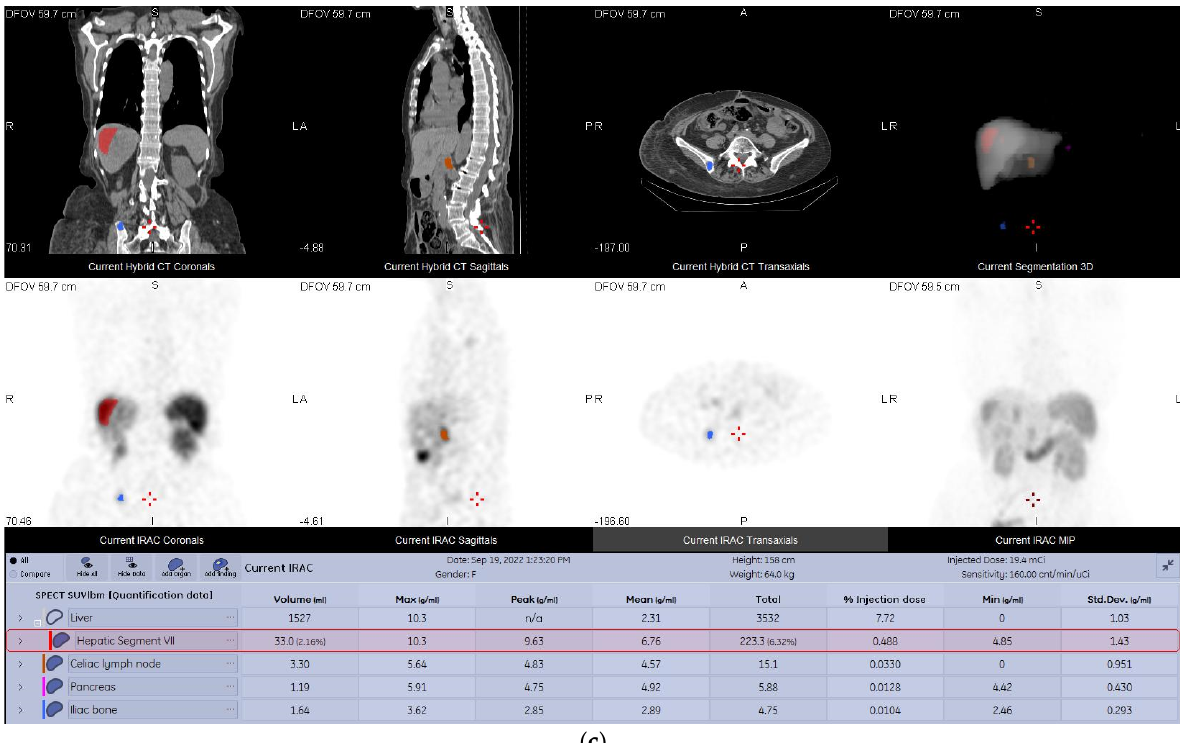
Figure 4. Comparison between a baseline and a follow-up scan of a 69 − year − old female patient suffering from pancreatic NET, treated with long acting somatostatin analogues. The comparative analysis between the baseline scan and the follow − up scan ( a ) shows a decrease in uptake both in the primary tumour (the pancreas) and in the liver metastasis. However, when analysing the two lesion segmentation processes separately, compared to the baseline scan ( b ), the follow − up scan ( c ) shows that new lesions developed in the lymph nodes and bones. This patient was finally classified as PD.